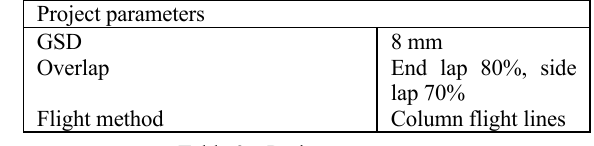
Table 3a. Project parameters